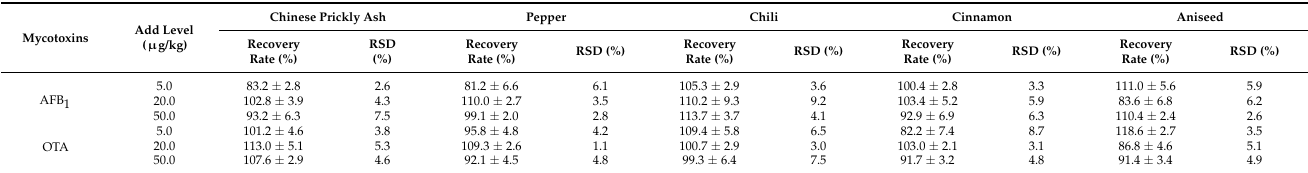
Figure 3. Test strip ( A ) T 1 line and ( B ) T 2 line specific test results. Table 3. Precision of test